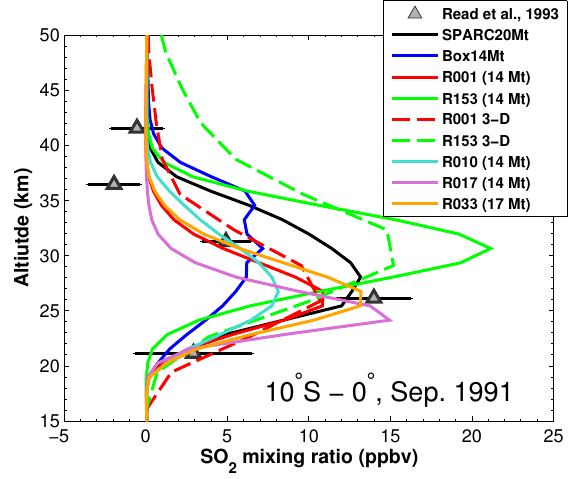
Figure 2. Vertical profiles of monthly zonal mean SO 2 mixing ratio at 10 ◦ S–0 ◦ N in September 1991. Different simulations are repre- sented in different colors. Observations (triangles) are taken from Microwave Limb Sounder (MLS) measurements (Read et al.,